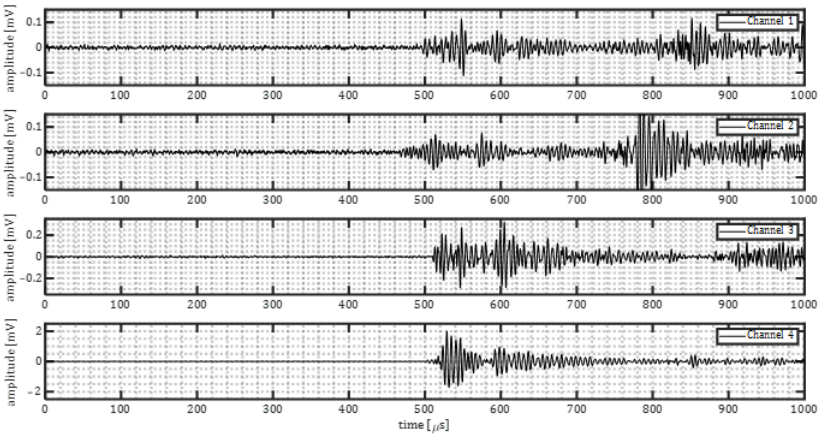
Figure 14. Samples of corrosion-induced signals for marine growth covered plate experiment.